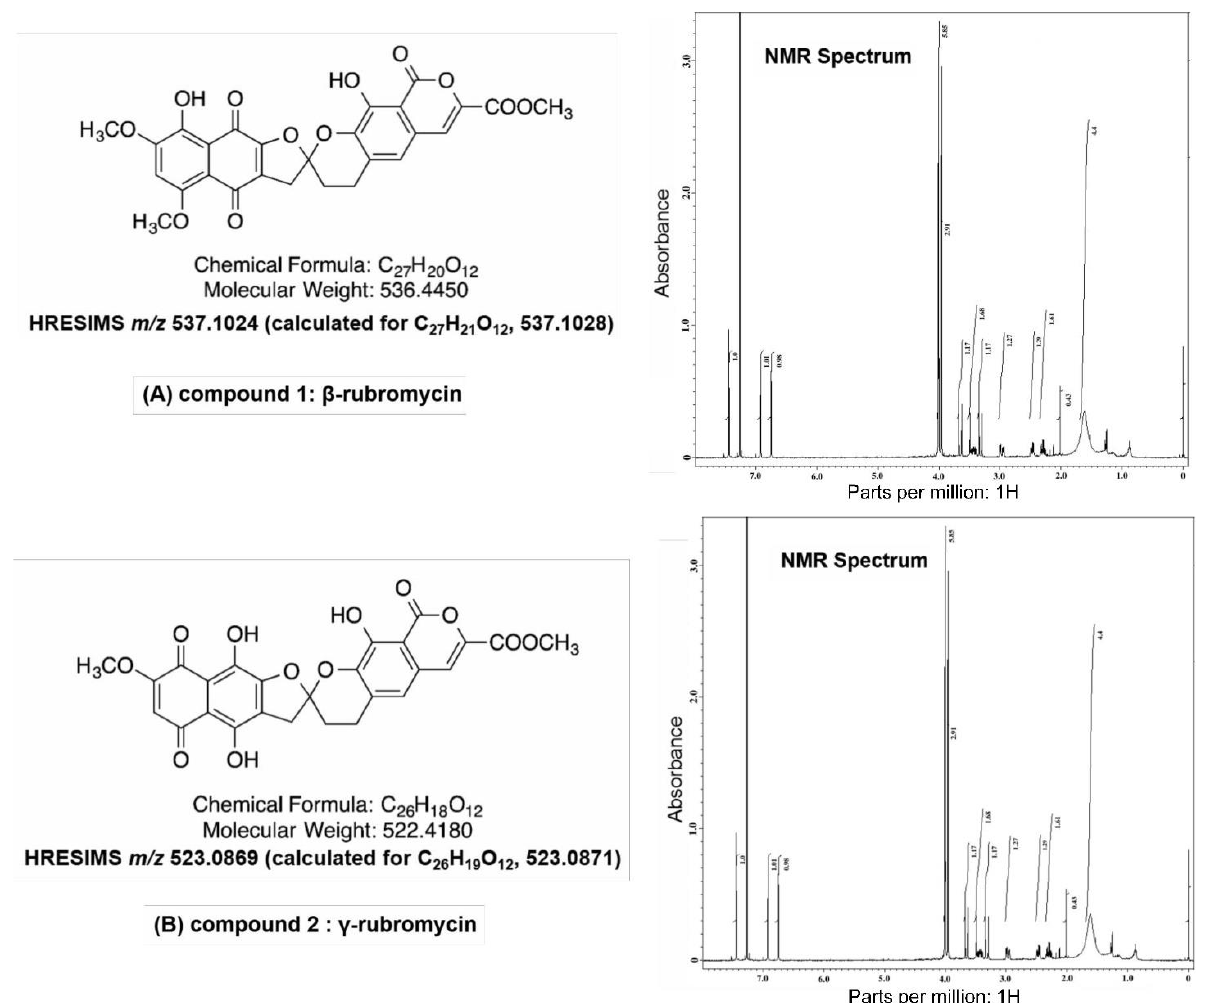
Figure 5. NMR spectra and chemical structures of ( A ) compound 1 , β -rubromycin, and ( B ) compound 2 , γ -rubromycin.